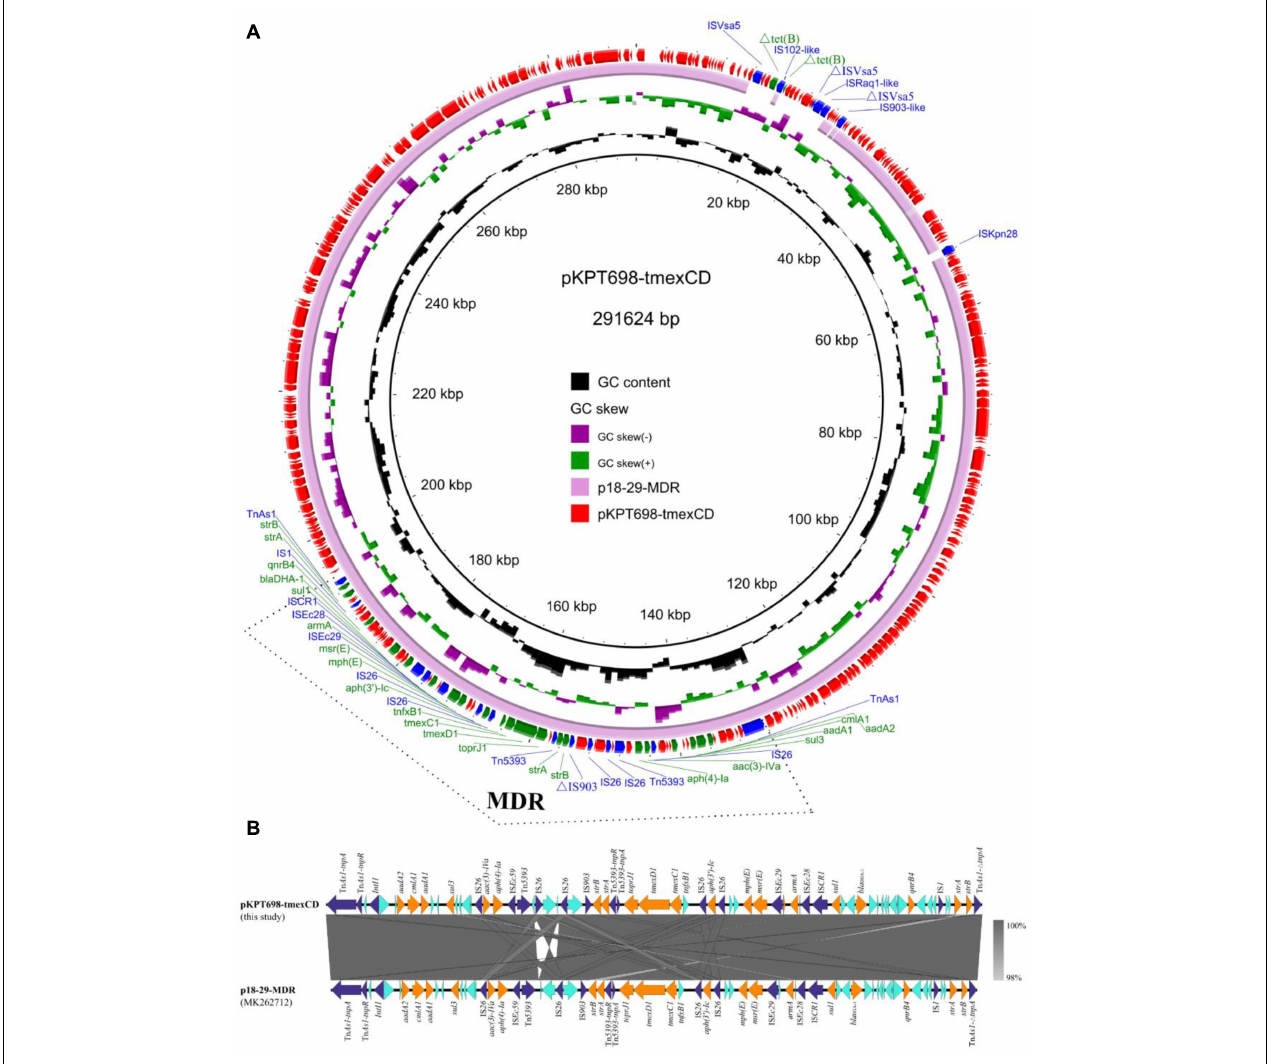
FIGURE 1 | (A) Circular plasmid map of pKPT698-tmexCD. Green, blue, and red arrows indicate the antimicrobial resistance genes, mobile elements, and other predicted ORFs, respectively. The names of antimicrobial resistance genes, mobile elements are labeled alongside the corresponding arrows. The multi-drug resistant (MDR) region is indicated with dotted line frame. (B) Linear comparisons of the MDR region in plasmids pKPT698-tmexCD and p18-29-MDR. Cyan, blue, and yellow arrows indicated the antimicrobial resistance genes, mobile elements, and other predicted ORFs,